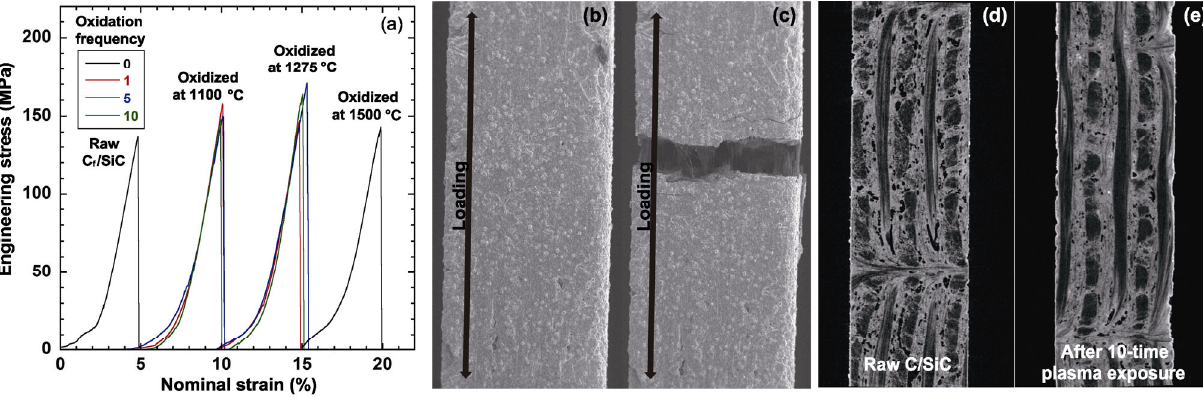
Fig. 12 (a) Stress–strain curves of C f /SiC “dog-bone” specimens after oxidation at various temperatures; (b, c) surface morphologies prior to and after uniaxial tension, respectively; and (d, e) meso-structure of raw C f /SiC and after 10-time plasma exposures at ~1275 ℃ ,